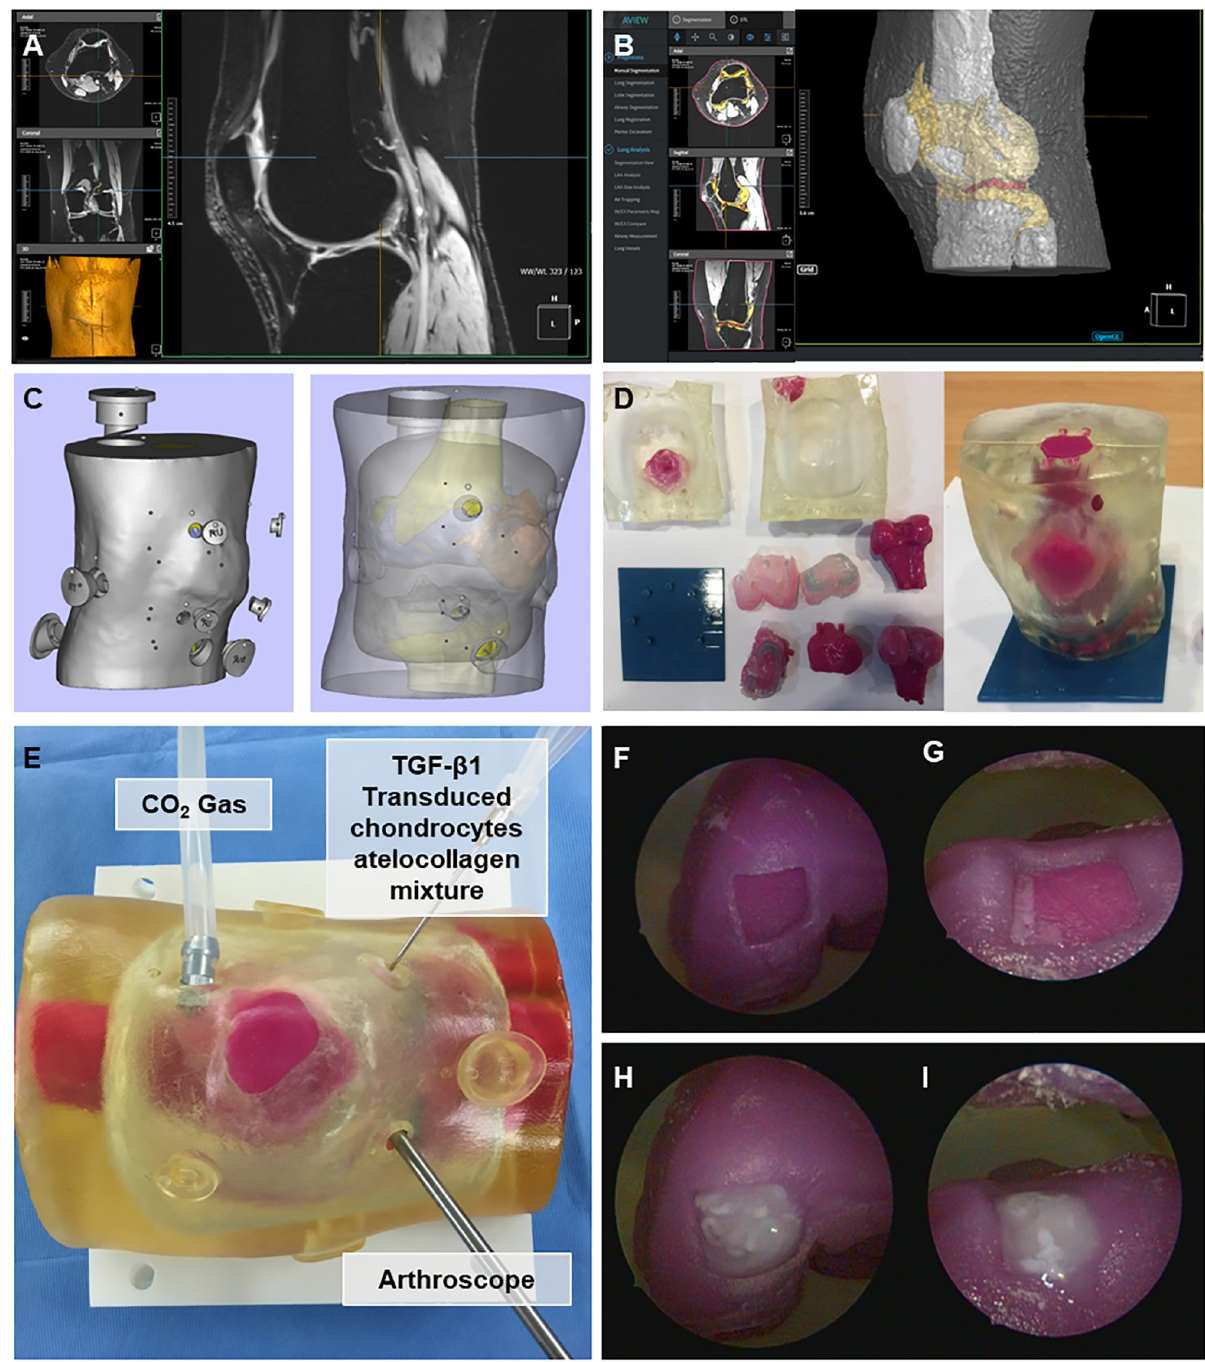
Fig 4. Process of knee joint model production using 3D printing technique. (A) Image segmentation based on the knee T2 magnetic resonance imaging data, (B) conversion of each divided part to stereolithography files, (C) implementation of functional elements with computer-aided design, and (D) output using a 3D printer. Arthroscopic application of TGF- β 1-transduced chondrocyte-atelocollagen mixture. (E) Knee joint model from the 3D printing technique. Arthroscopic findings after applying the TGF- β 1-transduced chondrocyte-atelocollagen mixture: (F) Medial femoral condyle defect, (G) trochlear defect, (H) application of the mixture to the medial femoral condyle defect, and (I) application to the trochlear defect.